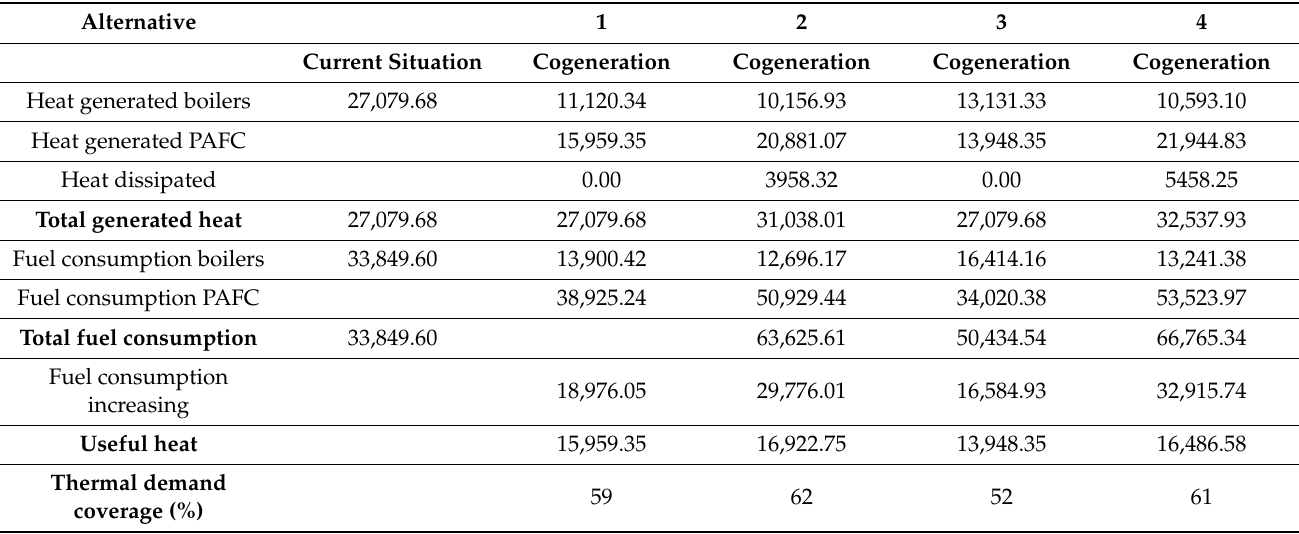
Table A1. Thermal Energy Balance (MWh/year) for alternatives considering 4 MW fuel cell power.